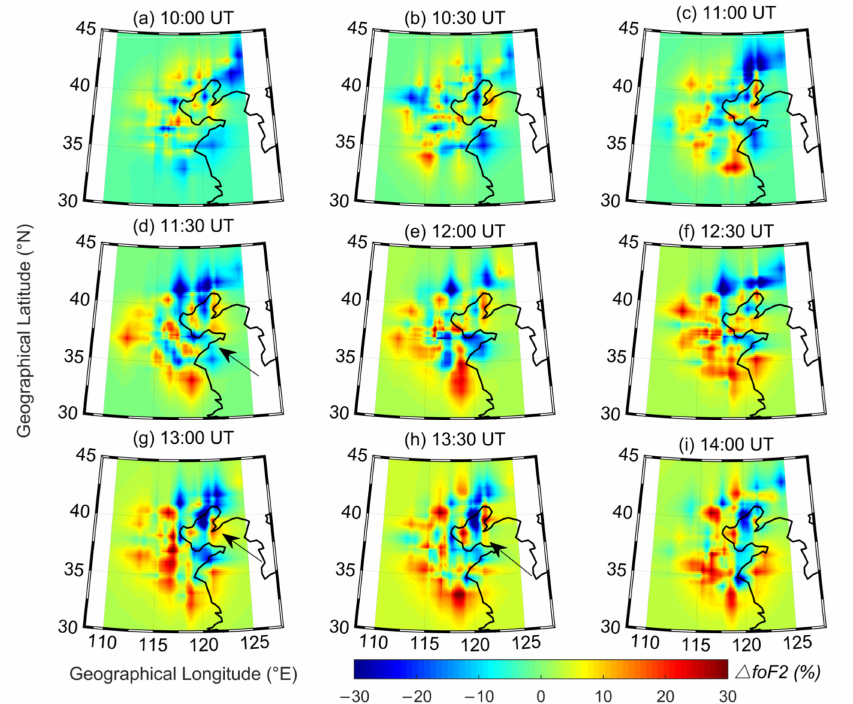
Figure 4. ( a – i ) Time sequences of two-dimensional ∆ f o F2 maps recorded from 10:00 UT to 14:00 UT on 11 March 2011 with a 30 min step. The black curve in each plot is the coastline of East Asia. The colorbar represents the magnitude of the ∆ f o F2 variations. The arrows indicate the ionospheric disturbances in the map. UT = LT − 8